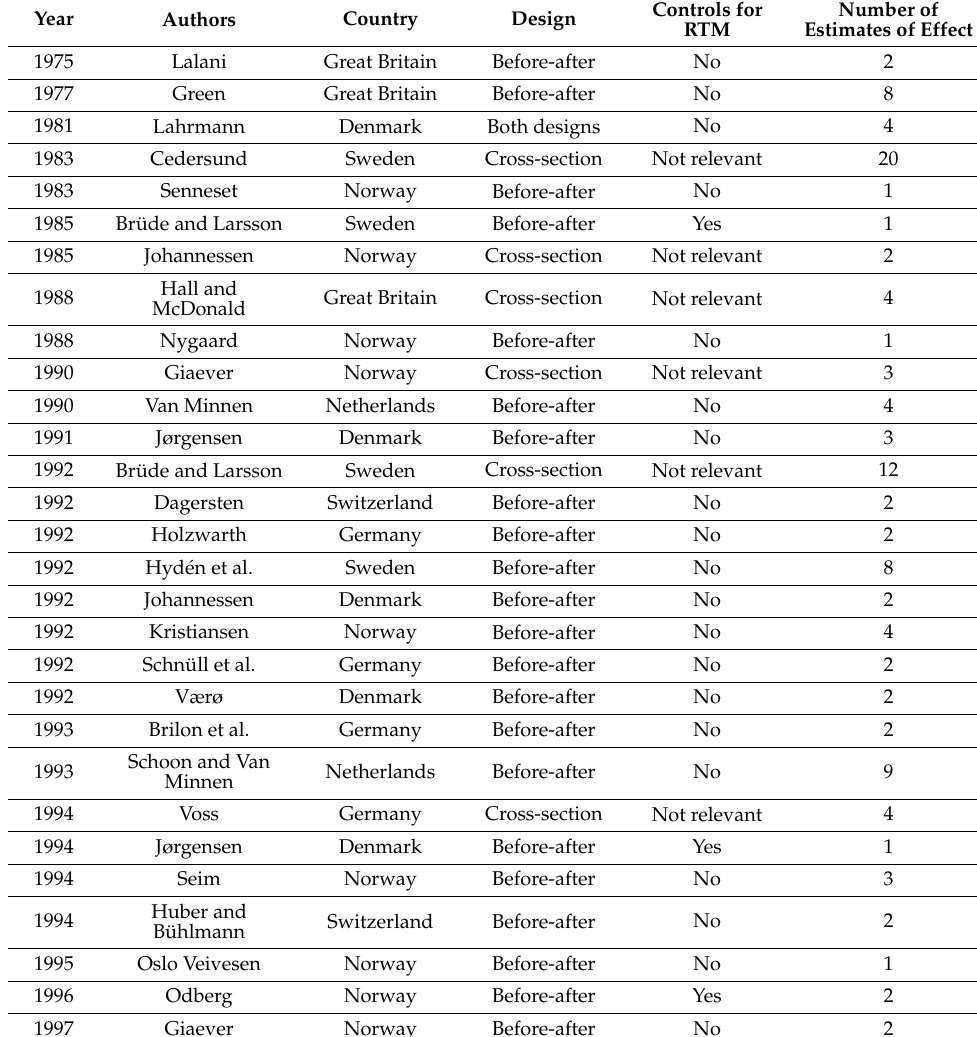
Table 1. List of Studies [13–50] Included in the Meta-Analysis-Based Research Conducted by Elvik (2003)